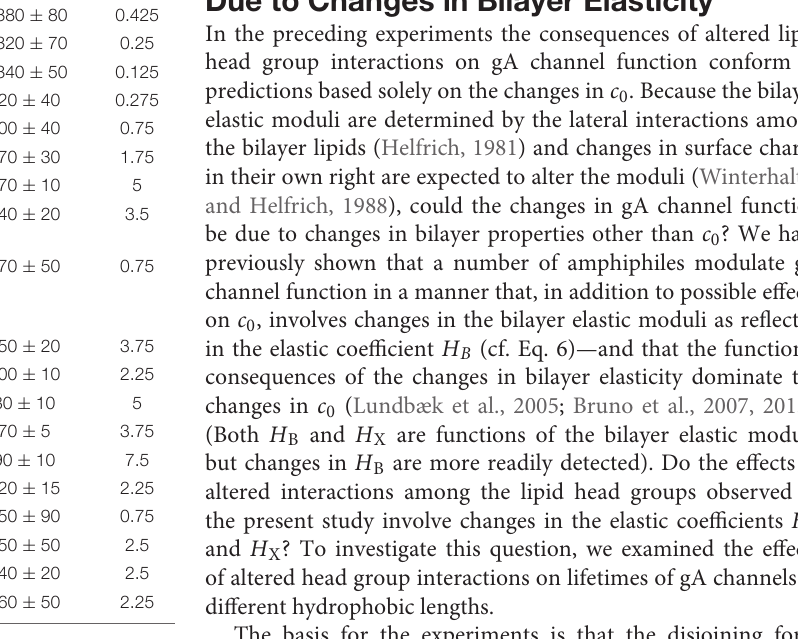
TABLE 2 | Changes in gA channel function and the amount of gA added to achieve f ≈ 1/s. Lipid, electrolyte g ± SD (pS) τ ± SD (ms) [gA] (pM) DOPS